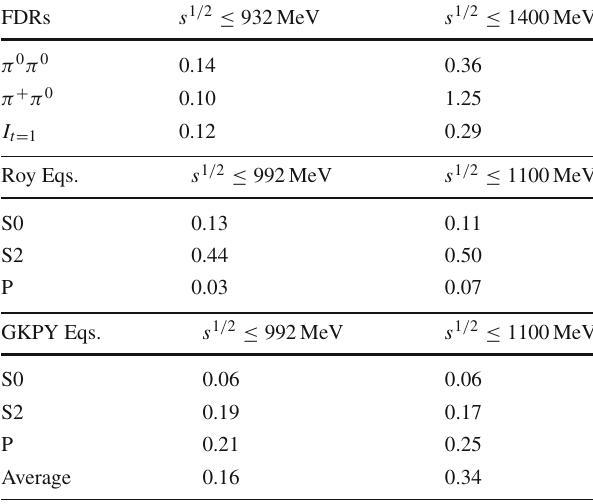
of our global parameterizations i